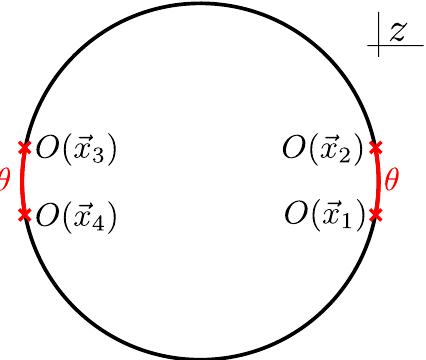
Figure 1 . The kinematics considered for the four-point function in the z plane. The black circle is the unit circle and the pairs of operators are inserted at an angle separation θ , with one pair centered at 0 and one pair centered at π